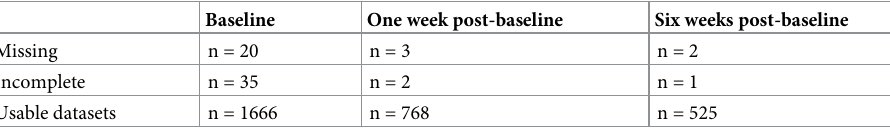
Table 2. Completeness of BQ data at all data collection